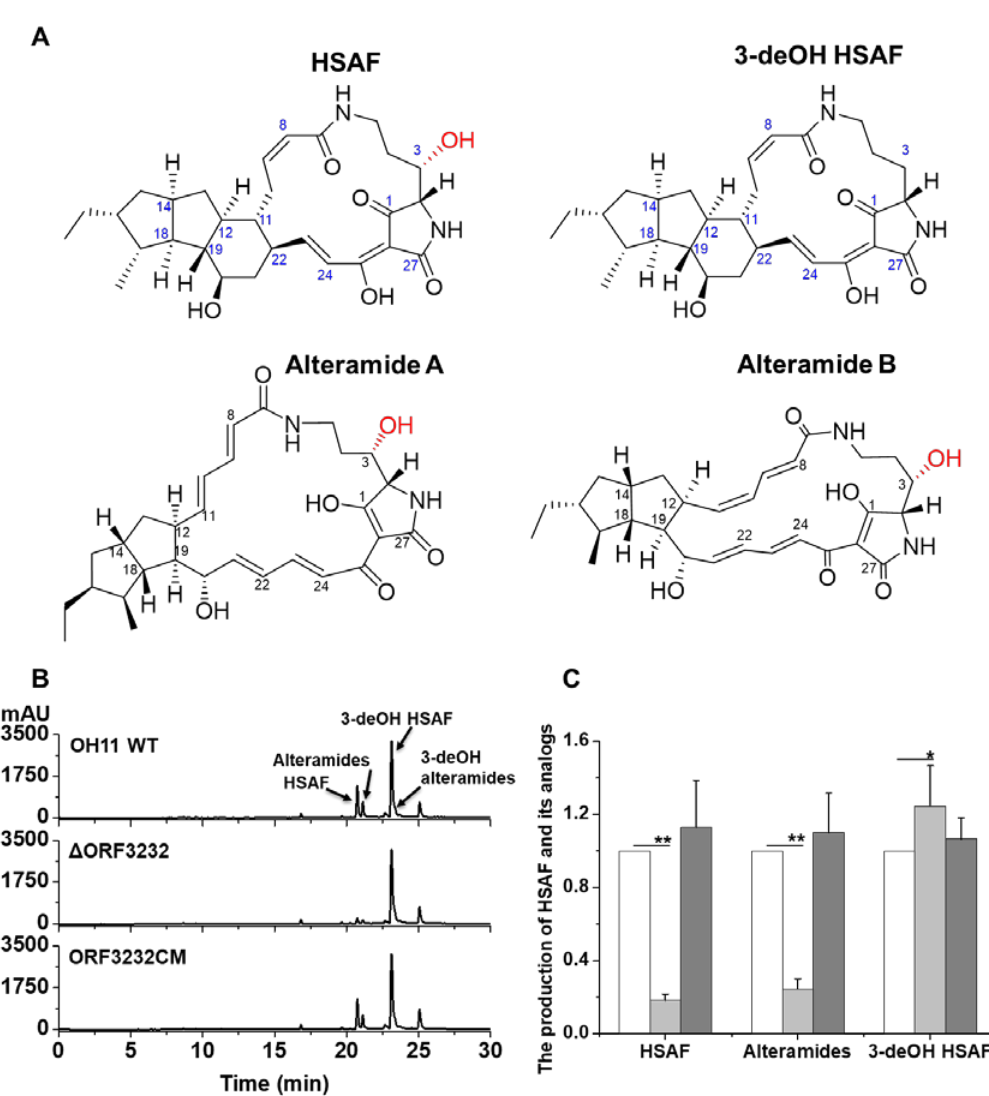
Figure 1. The antifungal HSAF and its analogs and impact of the deletion of the TetR family regulator, LeTetR, on their production in L. enzymogenes OH11. ( A ) Chemical structure of HSAF and its analogs produced in L. enzymogenes OH11. ( B ) HPLC analysis of HSAF and its analogs in strains WT, ∆ ORF3232 and ORF3232CM cultured in 1 / 10 TSB (Tryptic Soy Broth) medium for 48 h. ( C ) Quantification of HSAF and its main analogs in these strains. Note: As the 3-deOH alteramides were minor compounds and not well resolved from 3-deOH HSAF in HPLC, only 3-deOH HSAF was presented in the quantification. White columns, WT; light-gray columns, ∆ ORF3232; dark-gray columns, ORF3232CM. Data are presented as averages of three independent experiments, each conducted in triplicates, with * p < 0.05; ** p < 0.01.